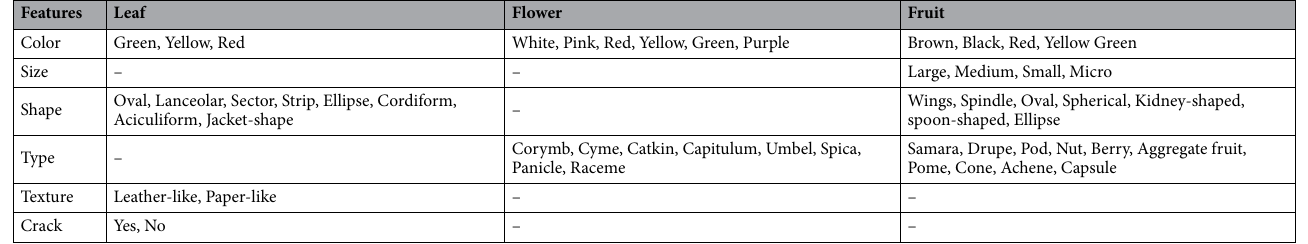
Table 2. Classification of organ characteristics and attributes of native greening plants in this